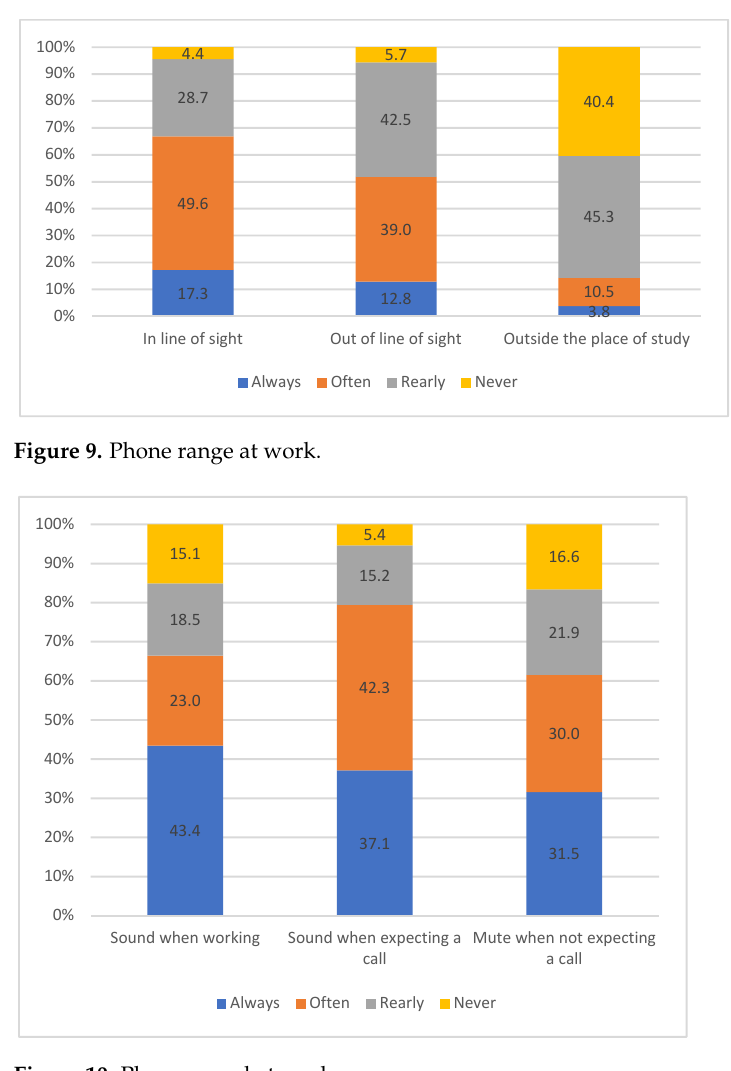
Figure 10. Phone sound at work.